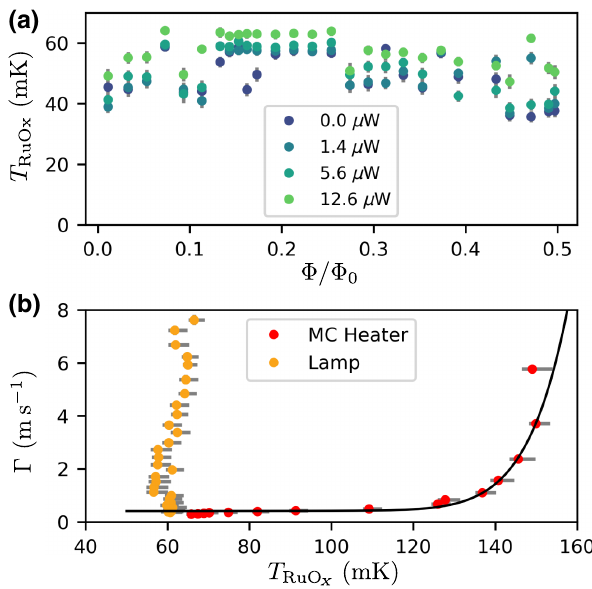
FIG. 13. (a) The temperature measured by the RuO 2 ther- mometer for the data of Fig. 4(c). The colors correspond to different lamp powers. The thermometer is mounted on the cop- per bracket supporting the 3D readout cavity in which the qubit is embedded. The temperature remains well below the tempera- ture at which thermal QPs are generated for all values of (cid:5)/(cid:5) 0 and P lamp . (b) The measured parity-switching rate (cid:4) as a func- tion of the temperature measured by the RuO 2 thermometer near the readout cavity. Two sweeps are shown. In yellow, the lamp power is swept [Fig. 13(b)] and here we observe that the bracket temperature does not change significantly as (cid:4) increases by this mechanism. In red, the mixing-chamber temperature is swept by increasing the power dissipated by heaters on the mixing-chamber plate. The temperature measured by the RuO 2 thermometer increases as the mixing-chamber temperature rises but (cid:4) does not increase dramatically until approximately 125 mK. This shows that the slight temperature increases shown in (a) cannot be responsible for the large increase in (cid:4) . The black line shows a fit to (cid:4) versus T , from which we may extract the average gap ¯ (cid:2)/ h ≈ 51.8